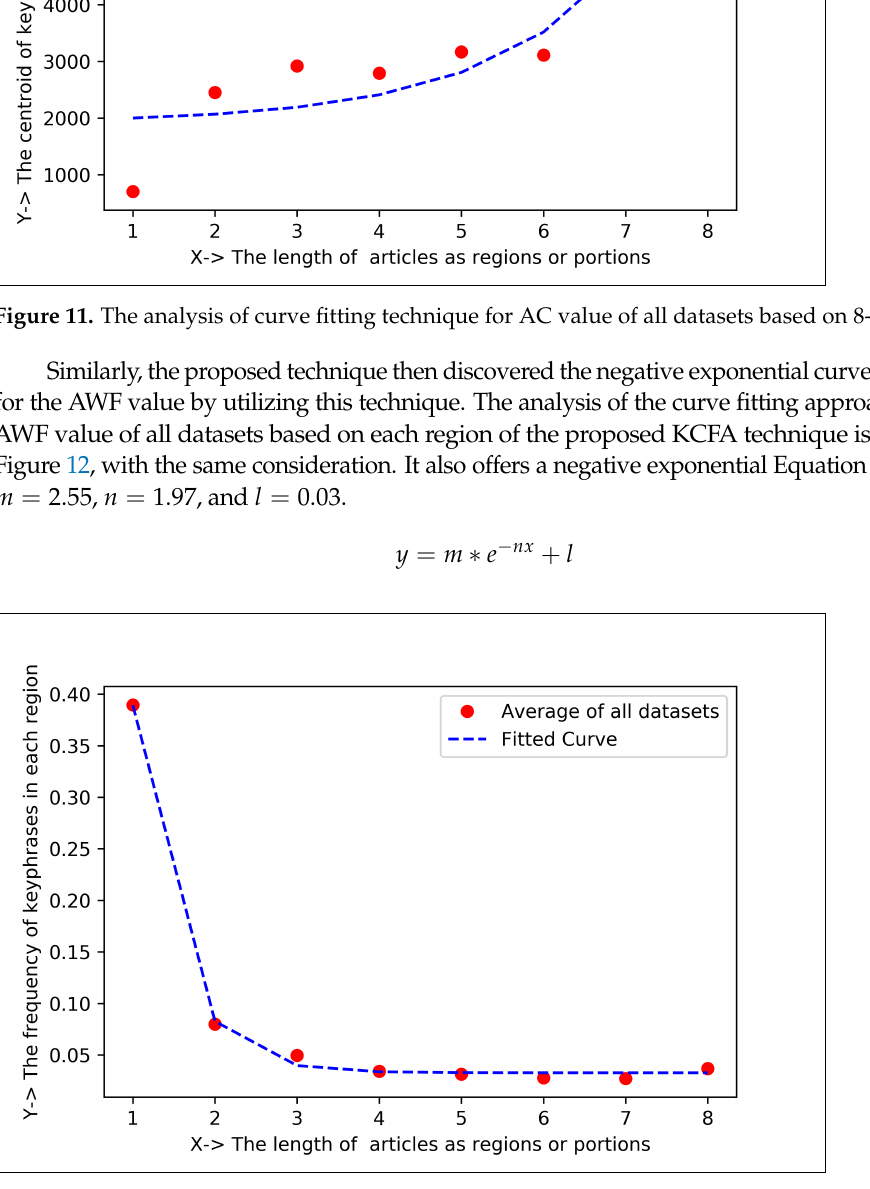
Figure 12. The analysis of curve fitting approach for the AWF value of all datasets based based on